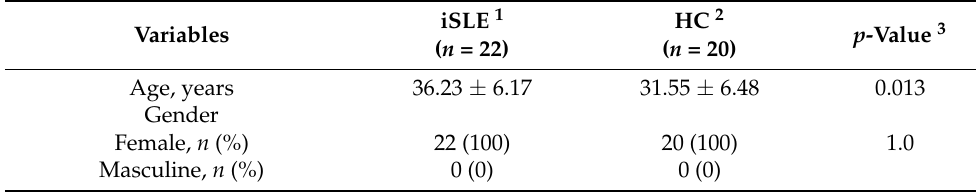
Table 1. Characterization of participants according to anthropometric, body composition, clinical and biochemical